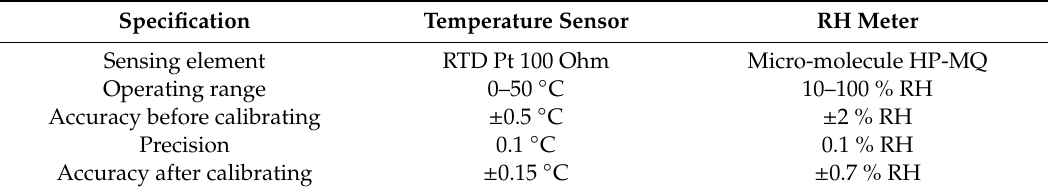
Table 1. Specifications of the Shinyei THT-V2-112-73-A2